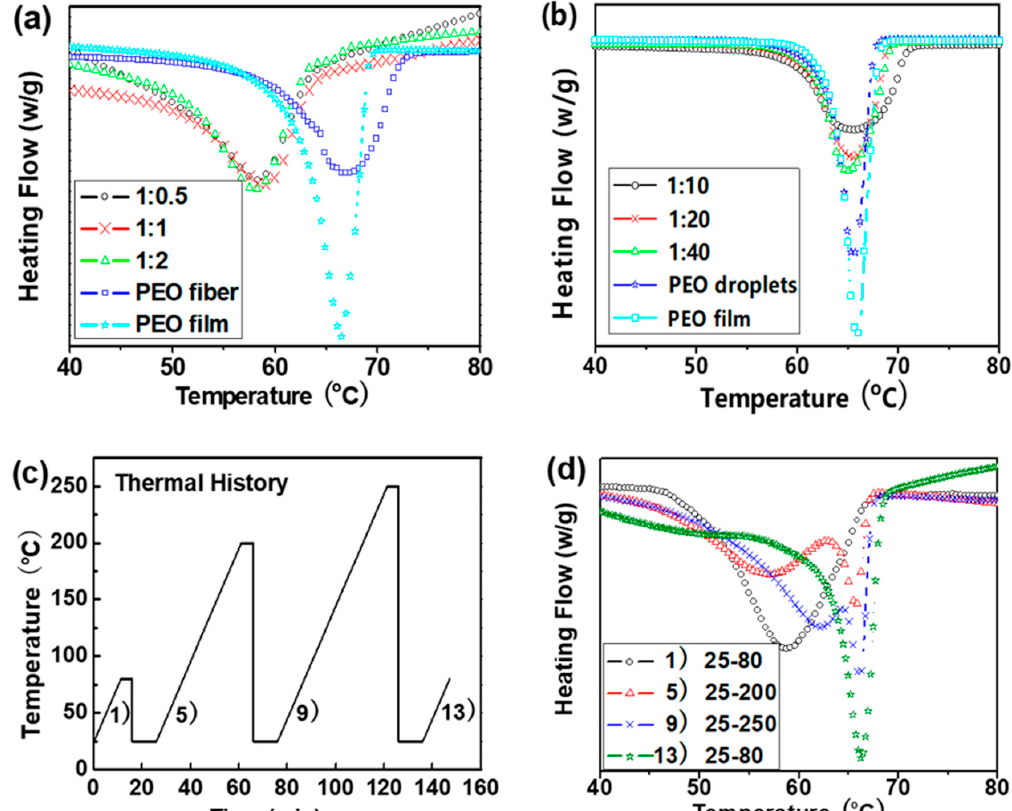
Figure 4. Di ff erential scanning calorimetry (DSC) -determined melting behaviors of: ( a ) HA / PEO-100 blended fibers, PEO-100 fibers and the casting film and ( b ) HA / PEO-2 blended fibers, PEO-2 fibers and Figure 4. Differential scanning calorimetry( DSC) -determined melting behaviors of: ( a ) the casting film. Melting behavior of the HA / PEO100 = 1:1 blended fibers under a continuous thermal HA/PEO-100 blended fibers, PEO-100 fibers and the casting film and ( b ) HA/PEO-2 blended fibers, process: ( c ) thermal process; and ( d ) DSC pattern of some of the related processes. PEO-2 fibers and the casting film. Melting behavior of the HA/PEO100 = 1:1 blended fibers under a continuous thermal process: ( c ) thermal process; and ( d ) DSC pattern of some of the related Table 2. Detailed data from the DSC patterns of the HA / PEO blended fibers and PEO fibers and processes. casting Table 2. Detailed data from the DSC patterns of the HA/PEO blended fibers and PEO fibers and casting films.